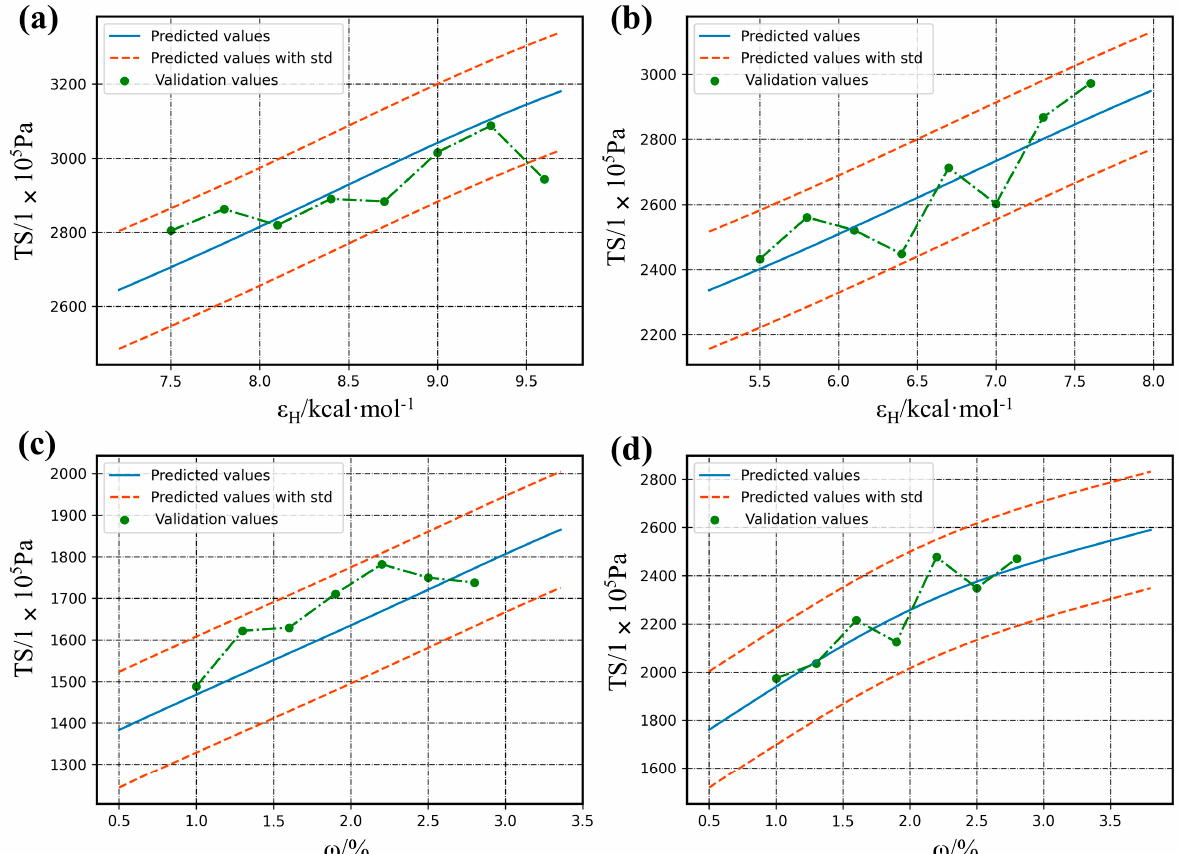
Figure 9. Comparison of the errors of the validation set and MD-XGB predictions, where ( a ), ( b ), ( c ) and ( d ) correspond to the four panels in Figure 8a.